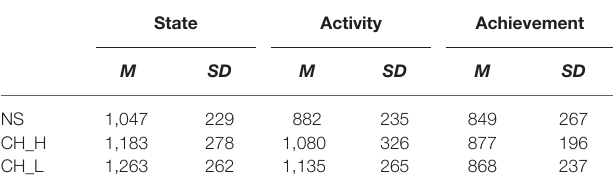
TABLE 5 | Mean and SD reaction times (ms) for past tense.